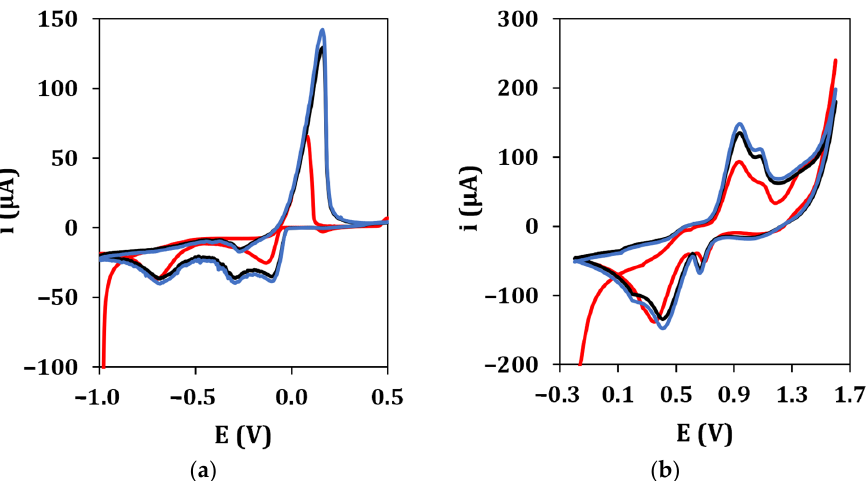
Figure 2. ( a ) AgNPs electrodeposition from a 2.5 mM AgNO 3 solution in 0.1 M NaNO 3 (•: 1st